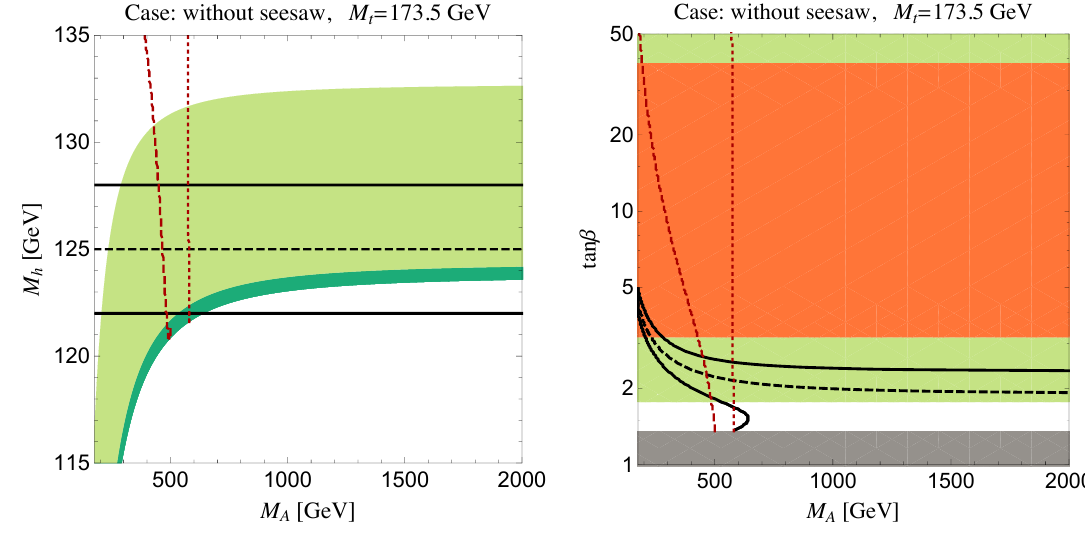
Figure 1 . Left panel: regions allowed in M A - M h plane by absolute stability (darker green) and metastability (green) of the scalar potential. Right panel: regions of absolute stability (unshaded), metastability (green) and unstability (orange) of the scalar potential in M A -tan (cid:12) plane. In the regions shaded by grey colour, the couplings become non-perturbative. In both the panels, the region between two black lines correspond to the values of M h in the range of 122{128 GeV while the dashed black line is for M h = 125 GeV. The region on the left side of vertical dotted and dashed red lines are disfavoured by the constraints, M > 580 GeV and j cos( (cid:12) (cid:0) (cid:11) ) j < 0 : 055, respectively. H (cid:6)